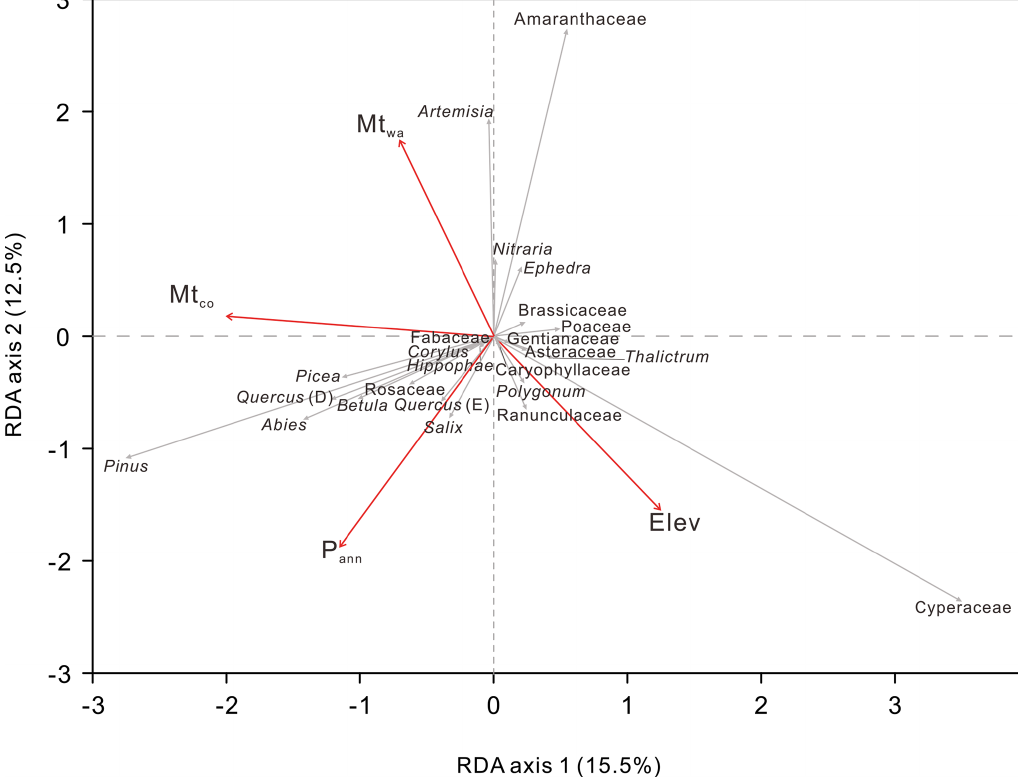
Clim. Past, 18, 2381–2399, 2022